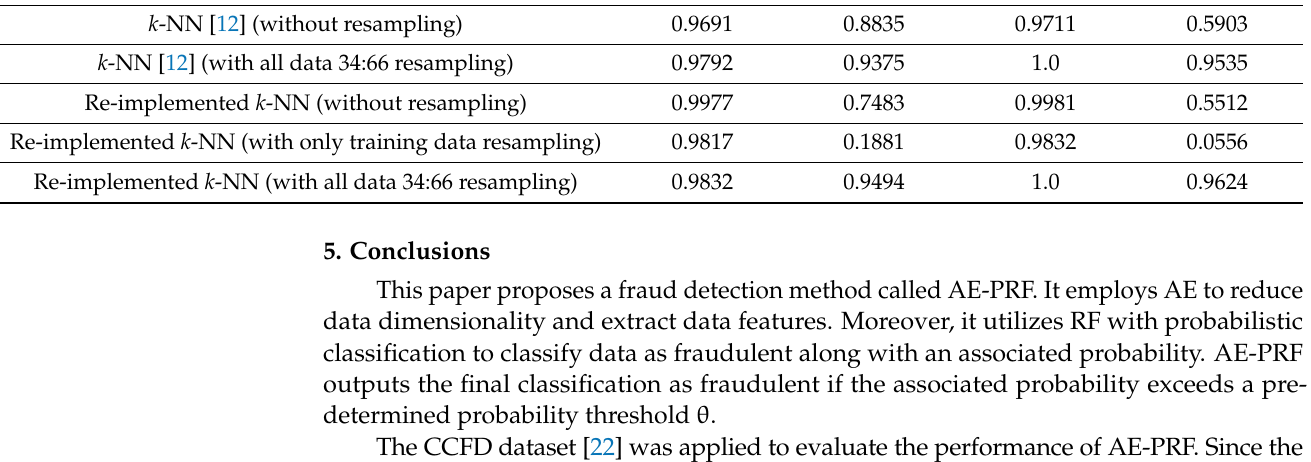
Table 4. Performance of k -NN [12] and re-implemented k -NN with and without data resampling.